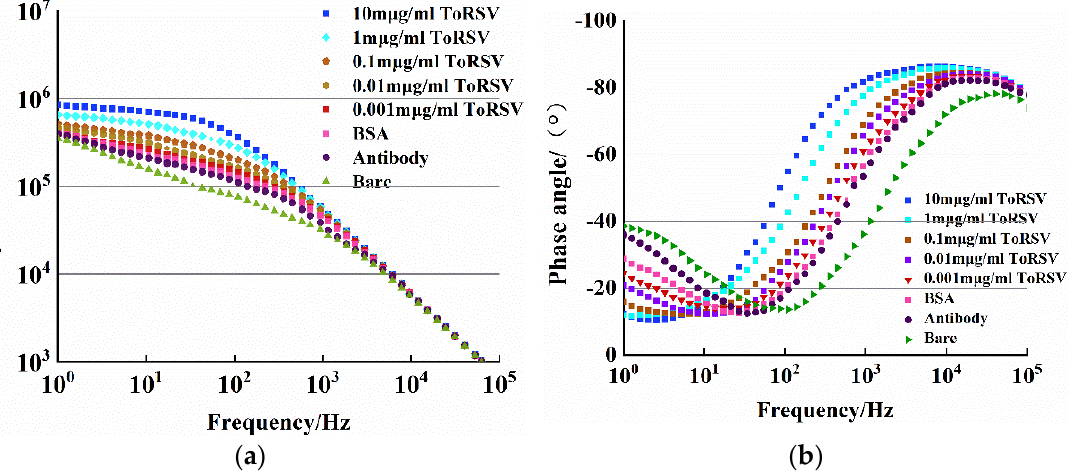
Figure 4. Impedance – frequency and phase angle – frequency curves of different solutions. ( a ) Im- pedance – frequency. ( b ) Angle –